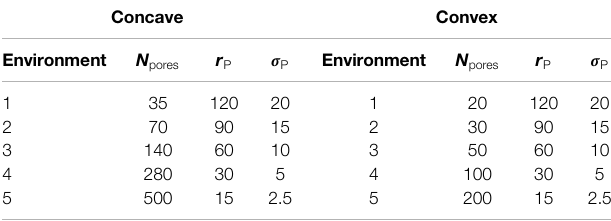
TABLE 1 | Parameters of the circular pores of the concave and convex porous medium. N pores isthenumberofcircularpores. r P istheaverageradius,and σ P is the standard deviation of the pore radius. Units of r P and σ P are pixels.